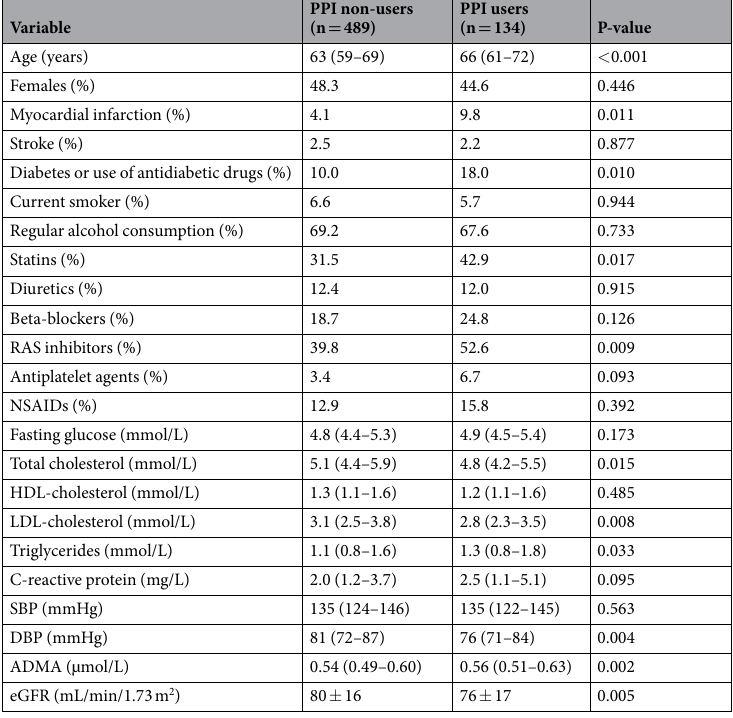
Table 3. Clinical and demographic characteristics of the Hunter Community Study cohort. PPI: proton pump inhibitor; RAS: renin-angiotensin system; NSAIDs: non-steroidal anti-inflammatory drugs; HDL: high-density lipoprotein; LDL: low-density lipoprotein; SBP: systolic blood pressure: DBP: diastolic blood pressure; ADMA: asymmetric dimethylarginine; eGFR: estimated glomerular filtration rate (Modification of Diet in Renal Disease formula).